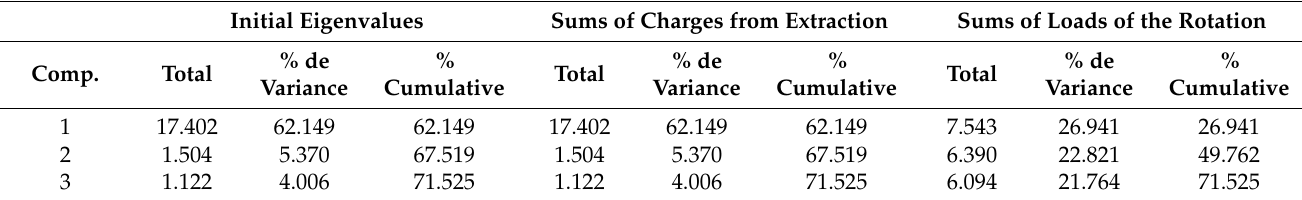
Table 12. Extraction of factors of ethical values ineffective communication.